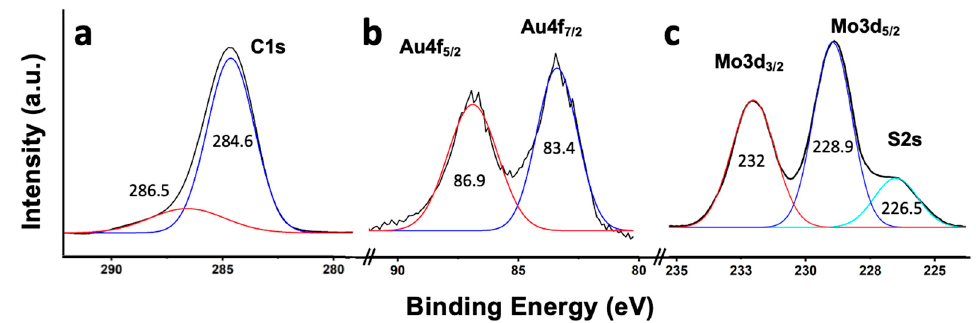
Figure 4. HR-TEM micrographs of the different components of the synthesized bundles of SWCNTs showing the diameter of an isolated nanotube ( a ); Au NP, showing the characteristics of face-centered-cubic (fcc) Au (111) (d = 0.23 nm) ( b ); and MoS2 single layer with the corresponding selected area electron diffraction (SAED) pattern ( c ).